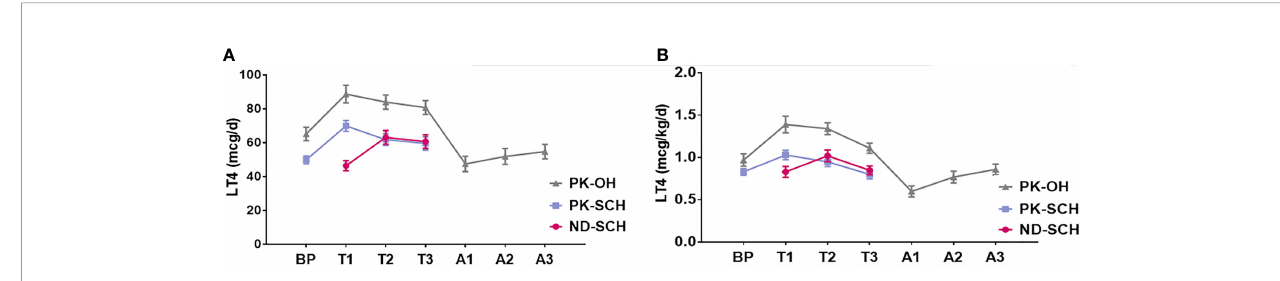
FIGURE 2 | LT4 dose adjustment before, during and after pregnancy. The whole pregnant women were followed up in every stage before, during and after pregnancy. Pregnant women with SCH stopped taking LT4 once they gave birth; As for pregnant women with PK-OH, LT4 dose were adjusted according to the dose before childbirth. Then adjusted LT4 dose accordingly in the light of the thyroid function postpartum. (A) shows the variations of daily LT4 dose (mcg/d) in each group and (B) shows weight adjusted LT4 dose (mcg/kg/d) in each